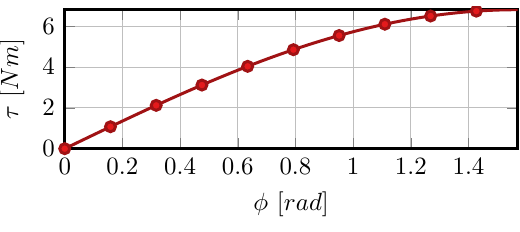
Figure 7. Maximum allowable input torque τ 1